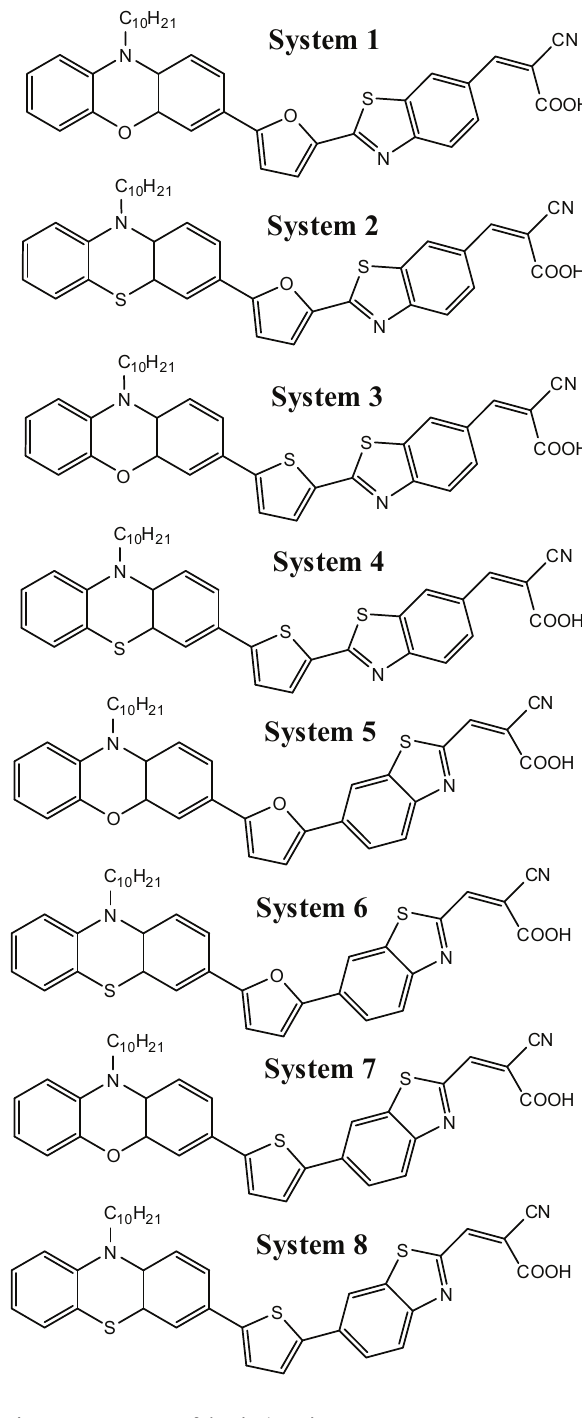
Figure 2: Structures of the designed